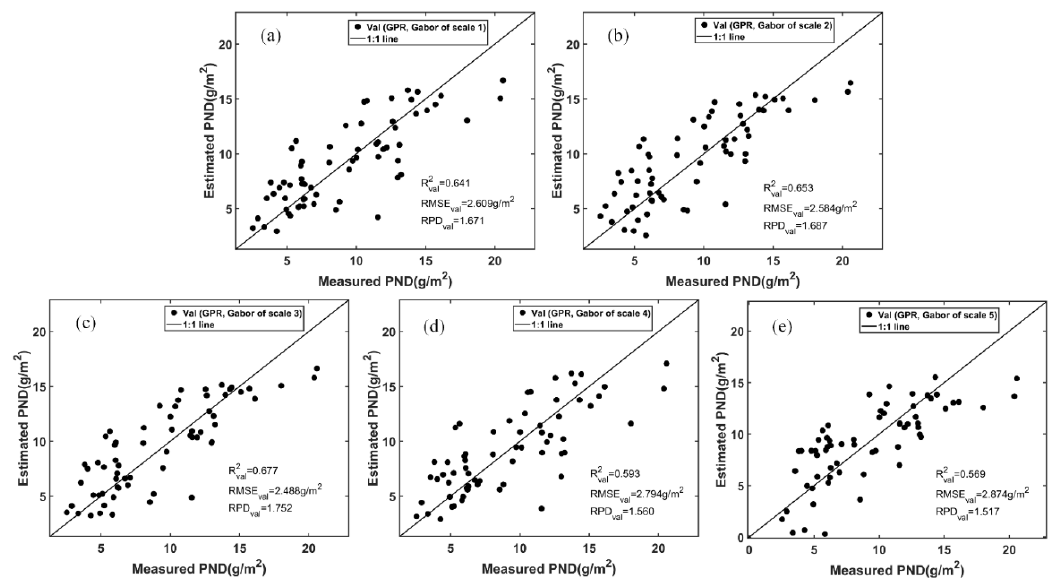
Figure 16. The predictive performance of the GPR models based on the Gabor-based textures of each scale for the estimation of PND in winter wheat ( a – e ).